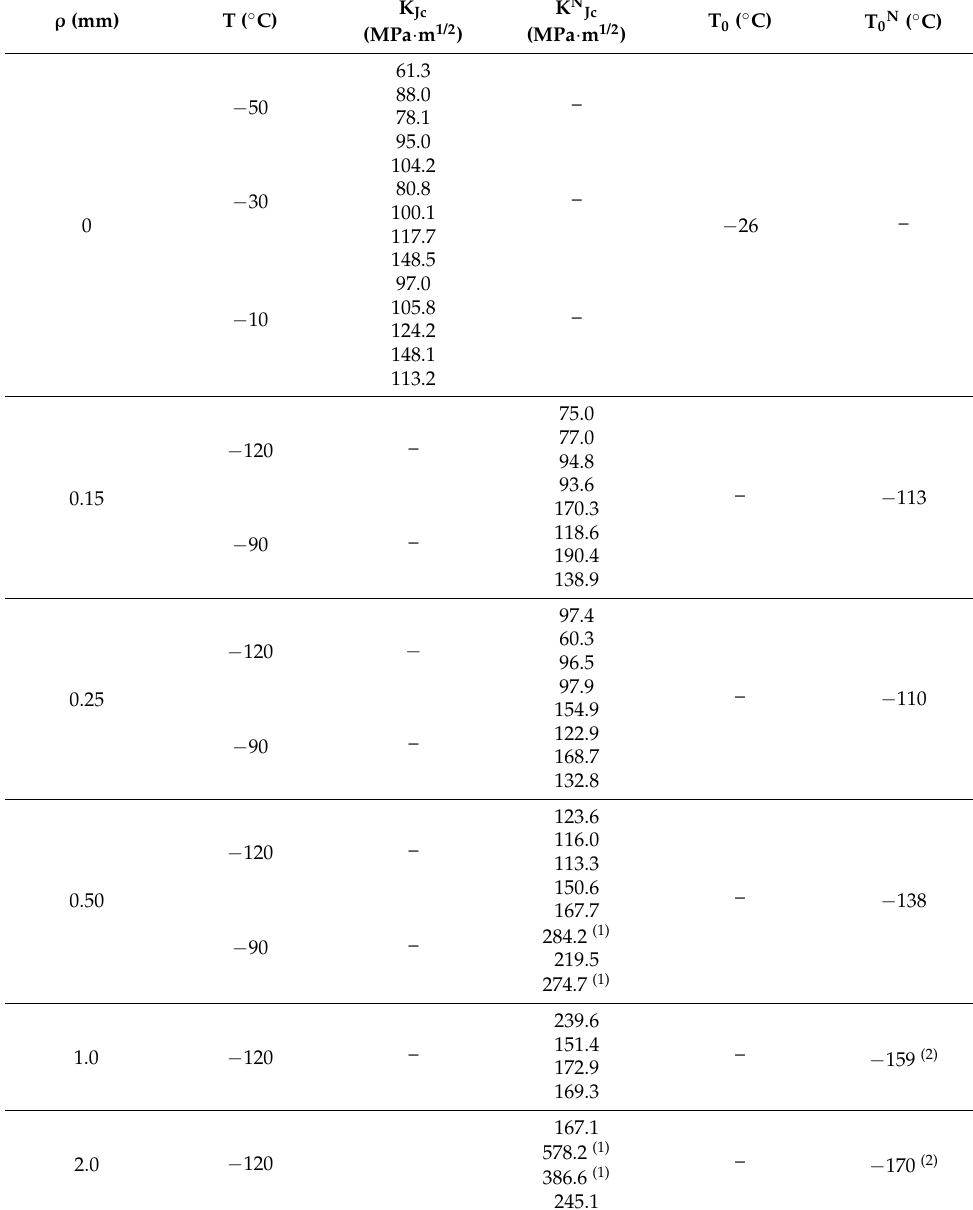
Table A1. Fracture toughness (K Jc ) and apparent fracture toughness (K N Jc ) results in steel S275JR, together with reference temperature results. 1T (25 mm thick) CT